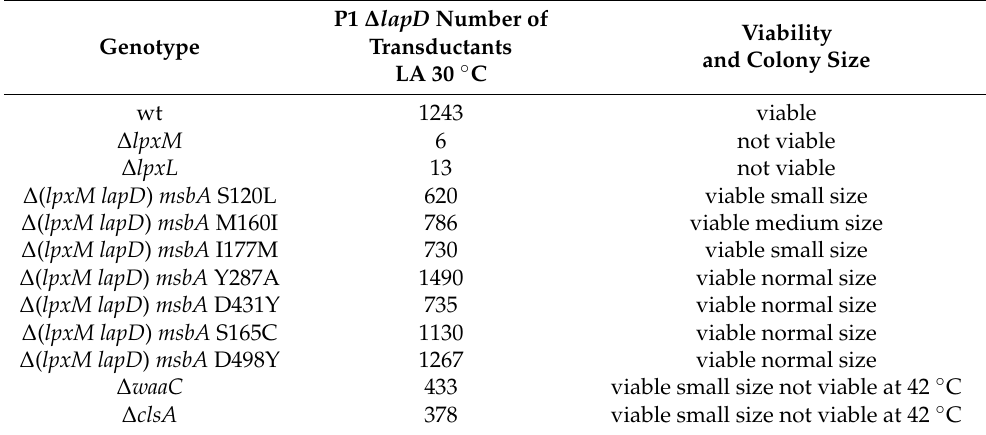
Table 2. Suppressor mutations mapping to the msbA gene can rescue the synthetic lethality of ∆ ( lpxM lapD ) bacteria as judged by their